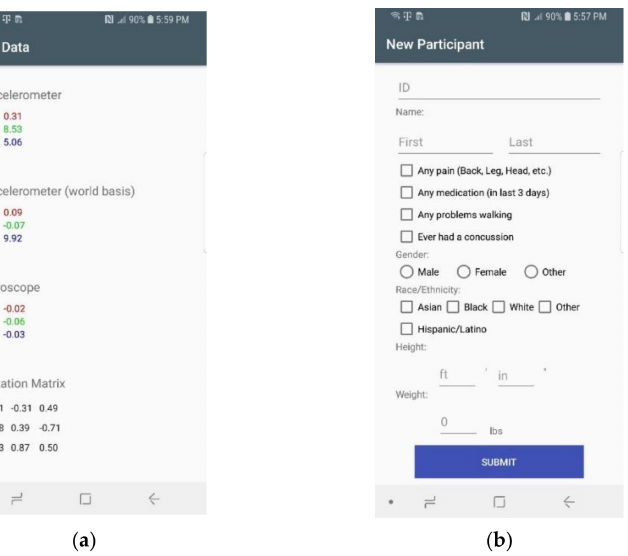
Figure 1. ( a ) The measuring sensor data in walking. Accelerometer, Gyroscope, and Rotation Matrix of XYZ were collected. ( b ) Subject information. Base information that can be related to walking was collected from